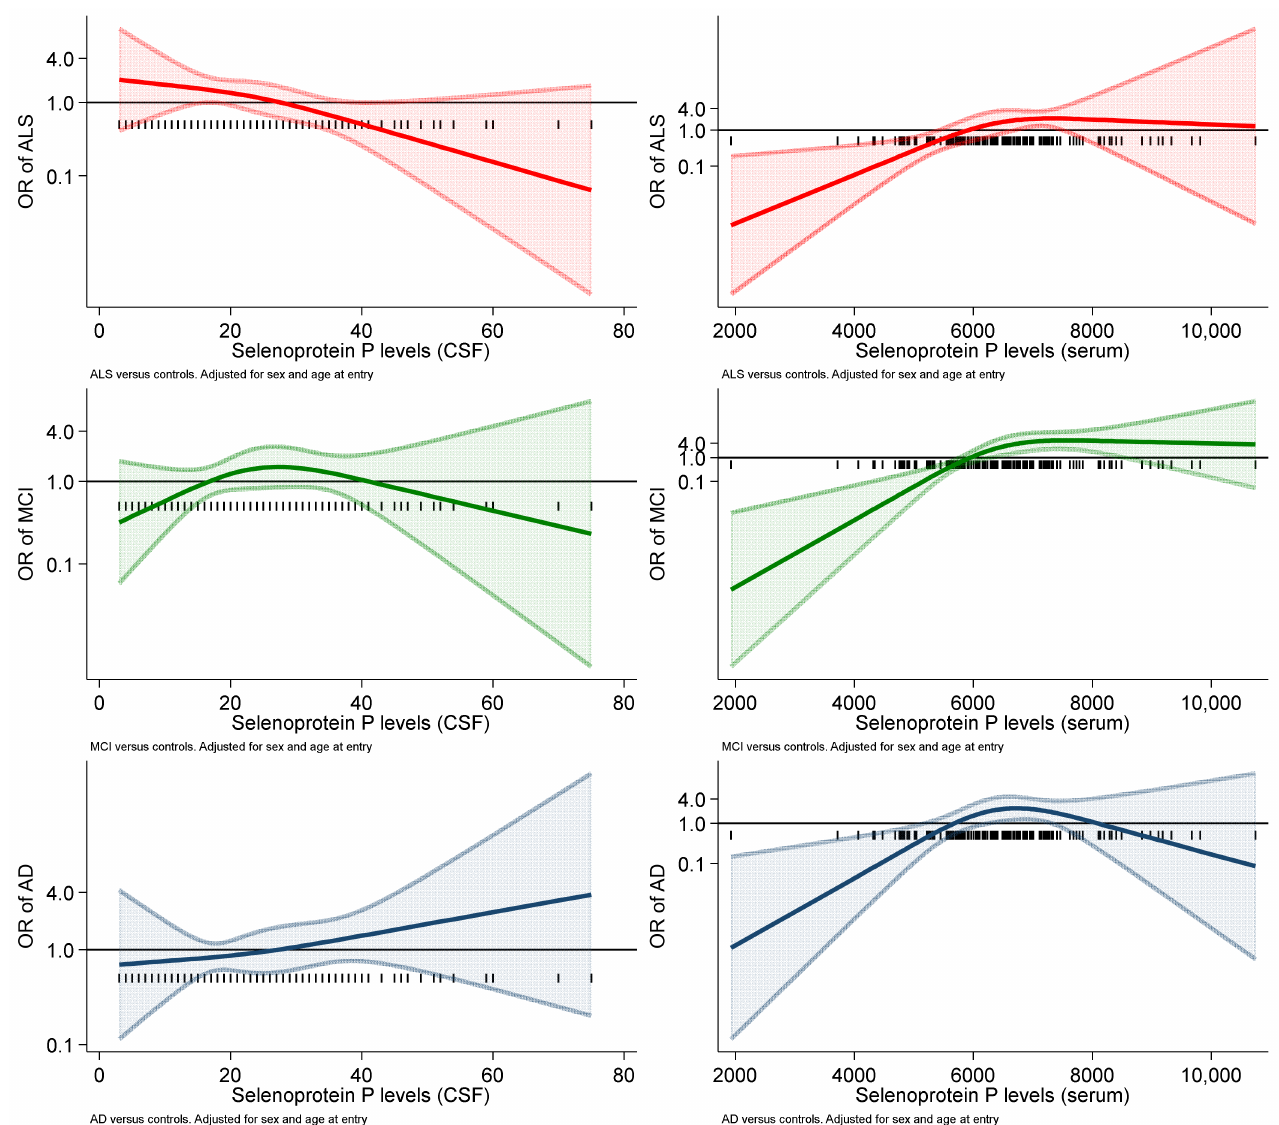
Figure 4. Association of selenoprotein P levels in cerebrospinal fluid (CSF) and in serum (ng/mL) with the odds ratio (OR) of Alzheimer’s dementia (AD), mild cognitive impairment (MCI) and amyotrophic lateral sclerosis (ALS) in spline regression analysis, with 95% confidence limits. The reference line at 1.0 with black spikes indicates the levels of selenoprotein P in the study